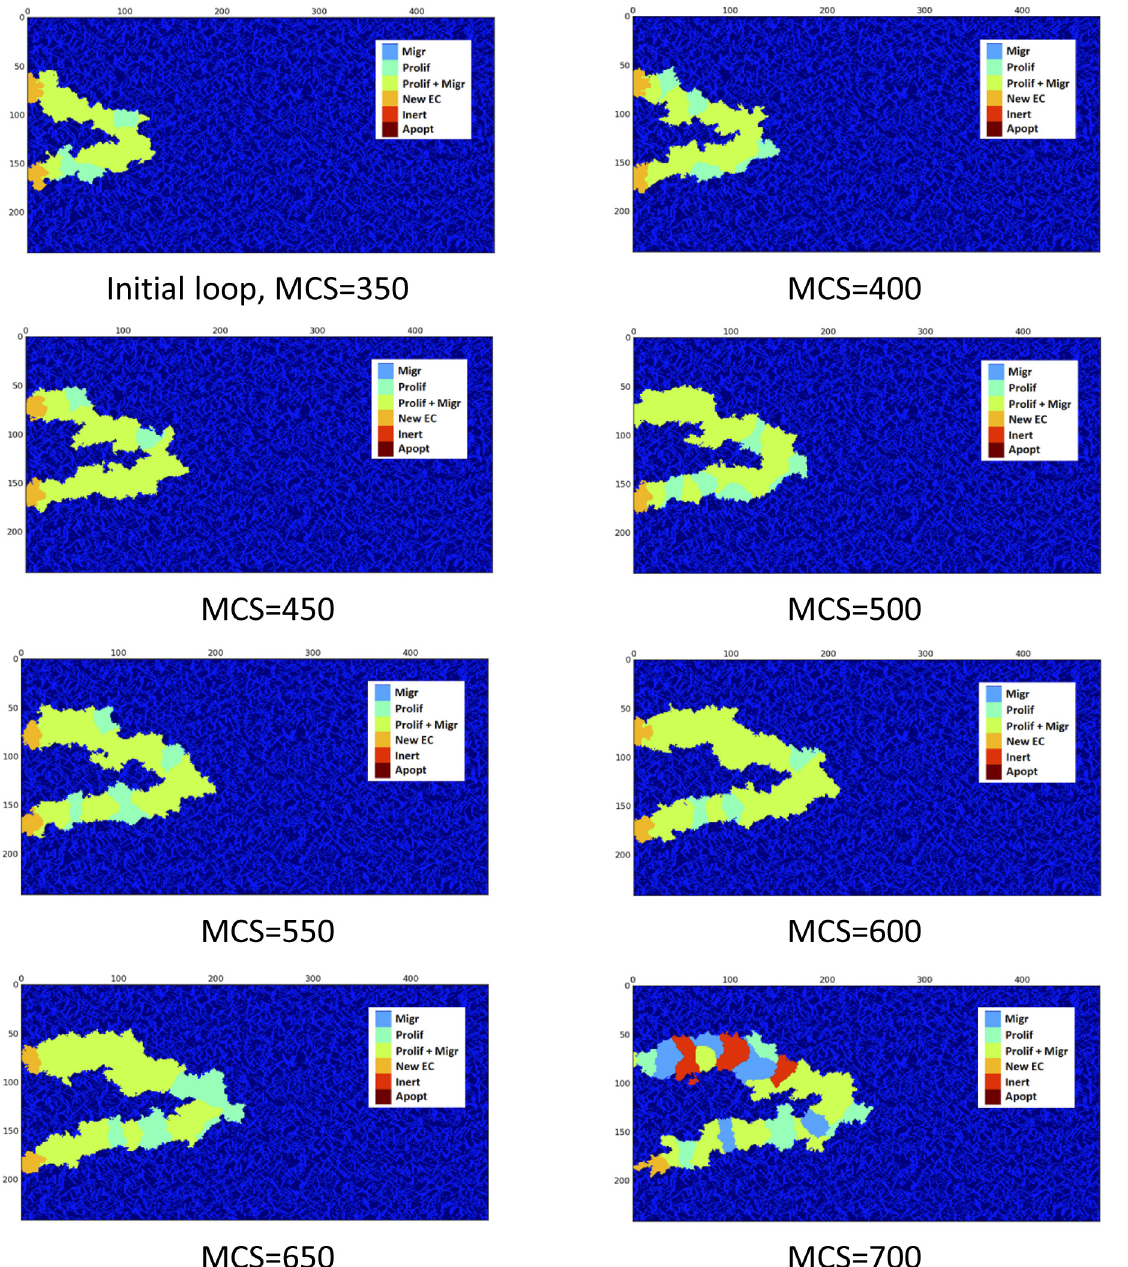
Fig 16. Phenotype distribution in ECs of a survived loop. Proliferation and migration is the dominant